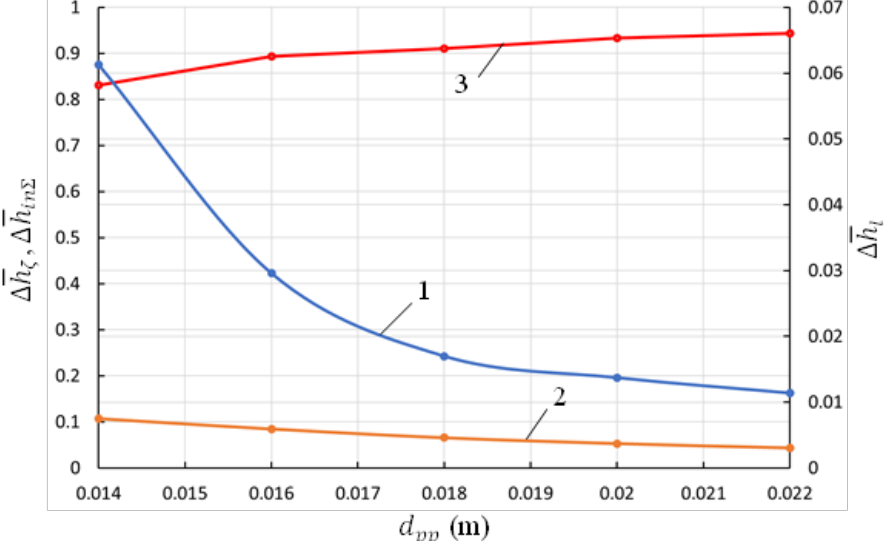
Figure 14. Dependence of the relative head losses along the length to overcome local resistances and inertial forces on the diameter of the supply pipeline (1- ∆ h l ; 2- ∆ h ζ ; 3- ∆ h in Σ ).